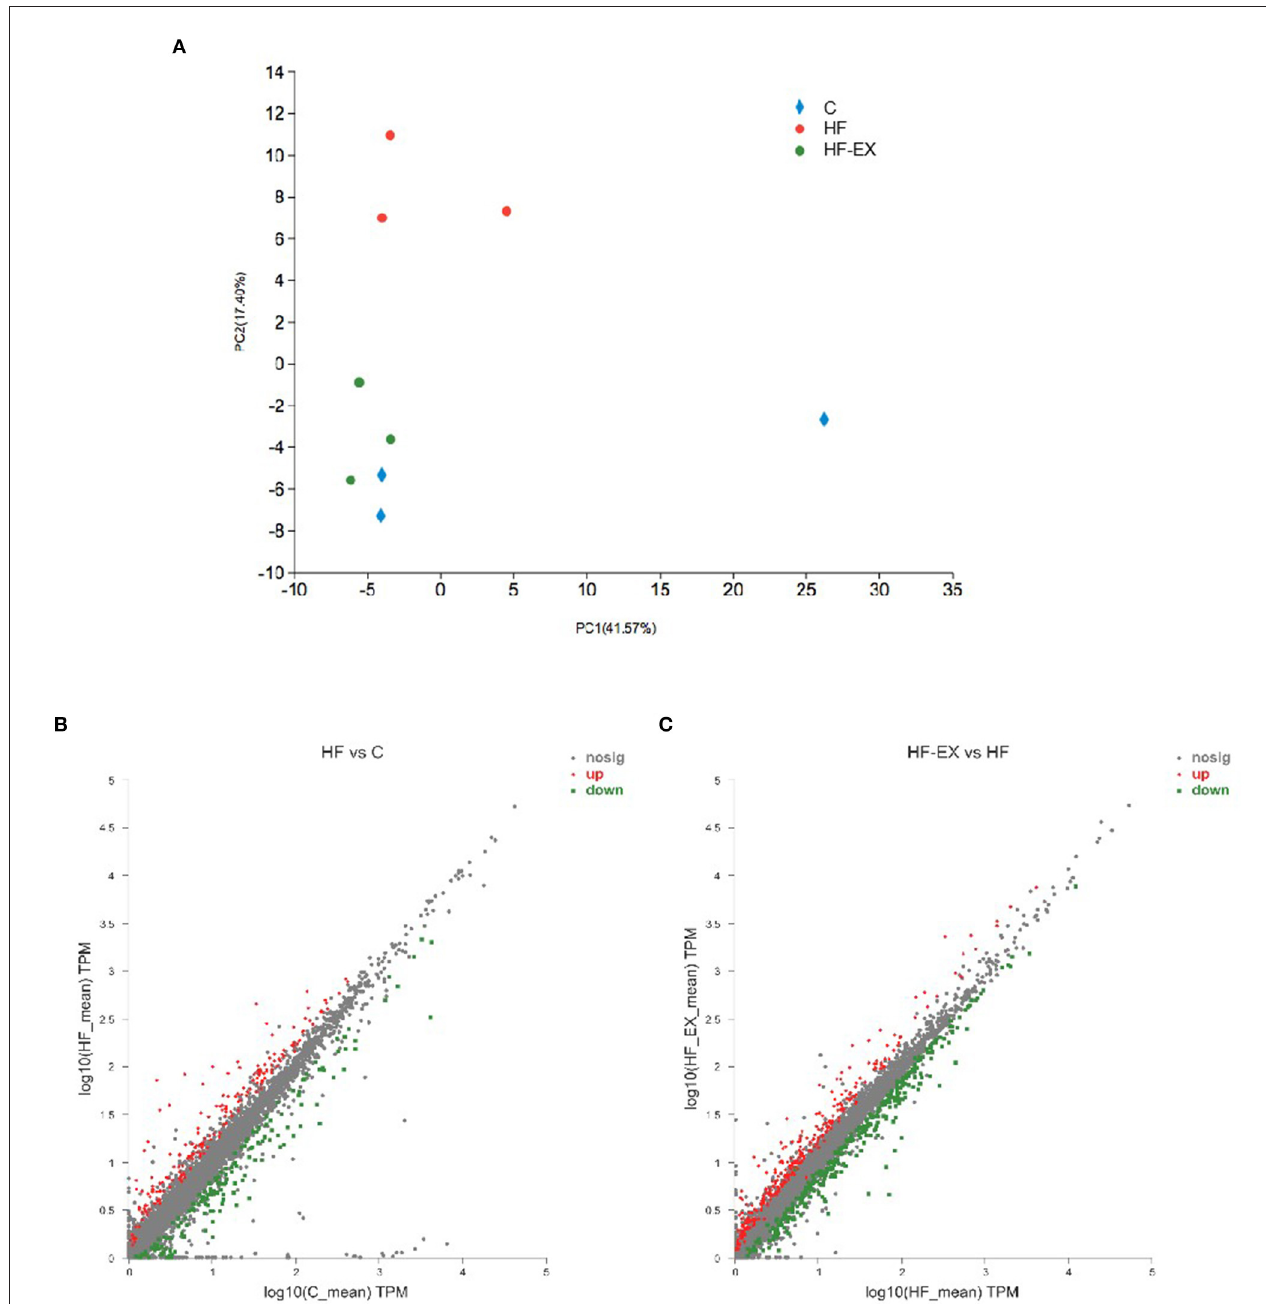
FIGURE 2 | Principal component analysis and scatter plot of hepatic transcriptome sequencing in adult offspring. (A) Principal component analysis; (B) scatter plot of HF vs. C; (C) scatter plot of HF-EX vs. HF. C, offspring of dams fed the normal control diet; HF, offspring of dams fed the high-fat diet; HF-EX, offspring of dams intervened with a high-fat diet and exercise ( n =